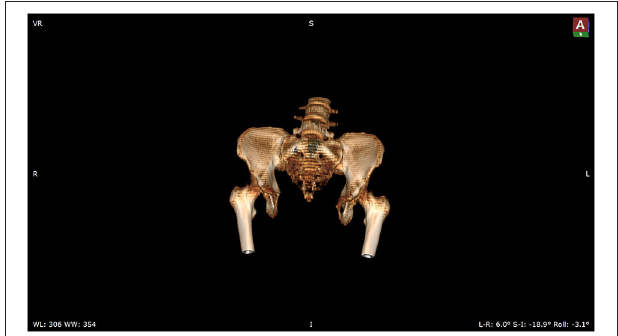
FIGURE 4 | Three dimensional-computed tomography reveals the separated pubic symphysis.